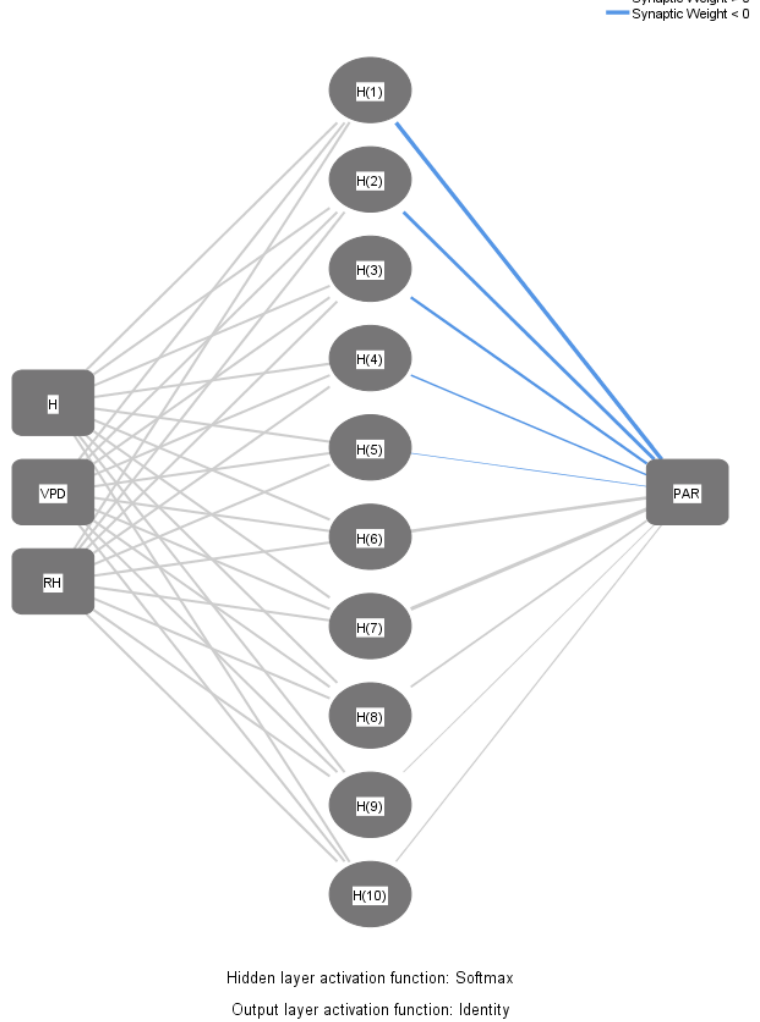
Figure 2. Schematic diagram of the best-performing model (model 11) using radial basis function (RBF).